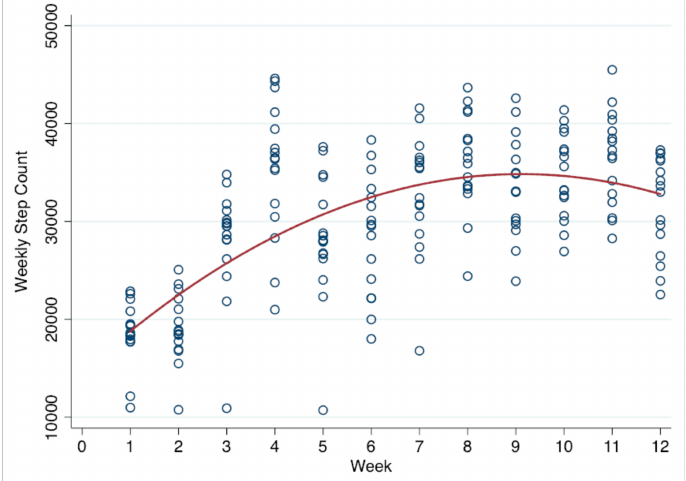
Figure 3. Quadratic time trend in step counts across